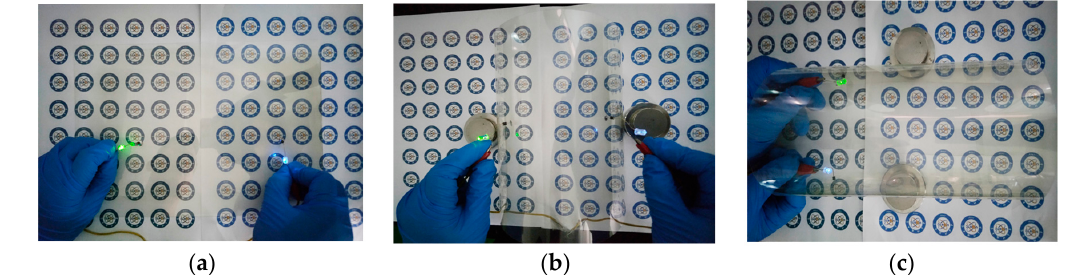
Figure 12. Photographs of devices containing green and blue LEDs the AgNWs film operating when ( a ) flat, ( b ) bent outward, and ( c ) bent inward.